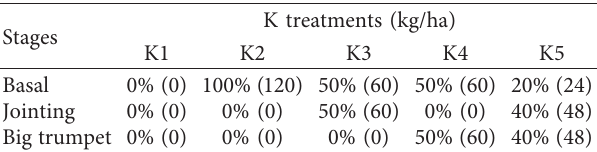
Figure 1: Monthly temperature, rainfall, and photosynthetically active radiation (PAR) average in 2017 and 2018. Table 1: Schedule, proportion, and amount of potassium fertilizer